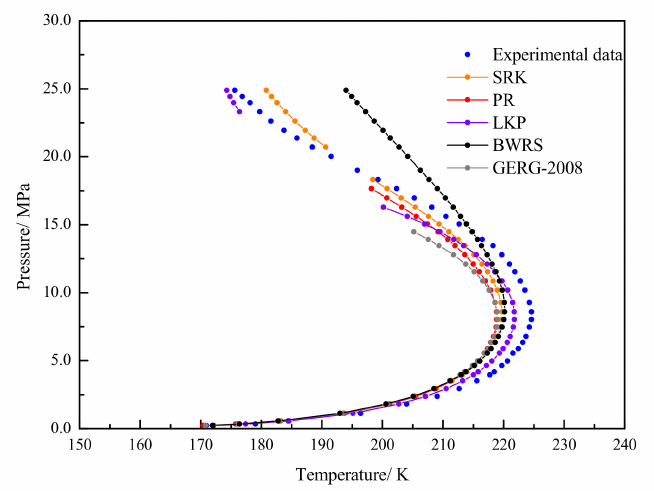
Figure 6. Experimental and calculation results of dew points for Sample